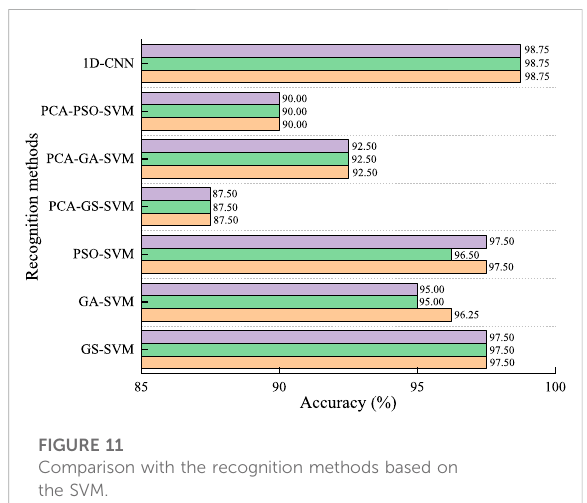
FIGURE 11 Comparison with the recognition methods based on the